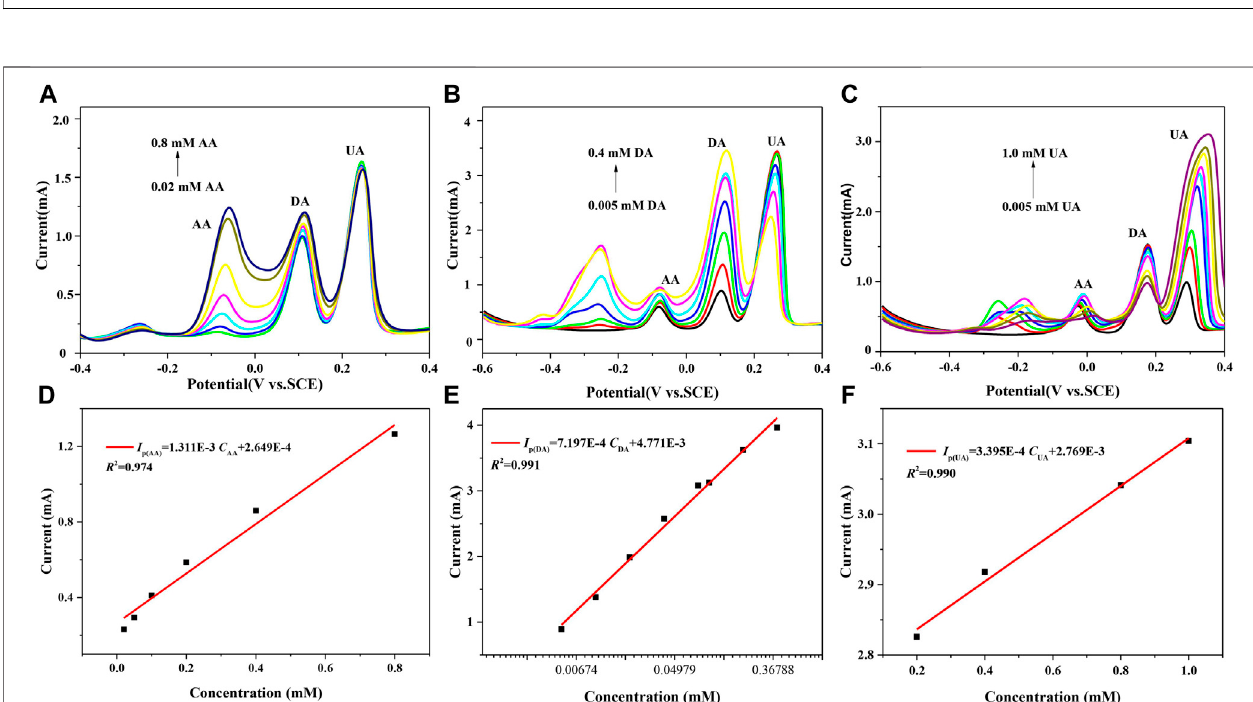
FIGURE 5 | 7 h GNSs/CC electrodes are used to detect AA, DA, and UA by DPV. (A) AA concentration changes, whereas DA and UA concentrations remain unchanged. (B) DAconcentrationchanges,whereasAAandUAconcentrationsremainunchanged. (C) UAconcentrationchanges,whereasAAandDAconcentrations remain unchanged. (D) The fi tting curve of peak current and concentration of AA. (E) The fi tting curve of peak current and concentration of DA. (F) The fi tting curve of peak current and concentration of